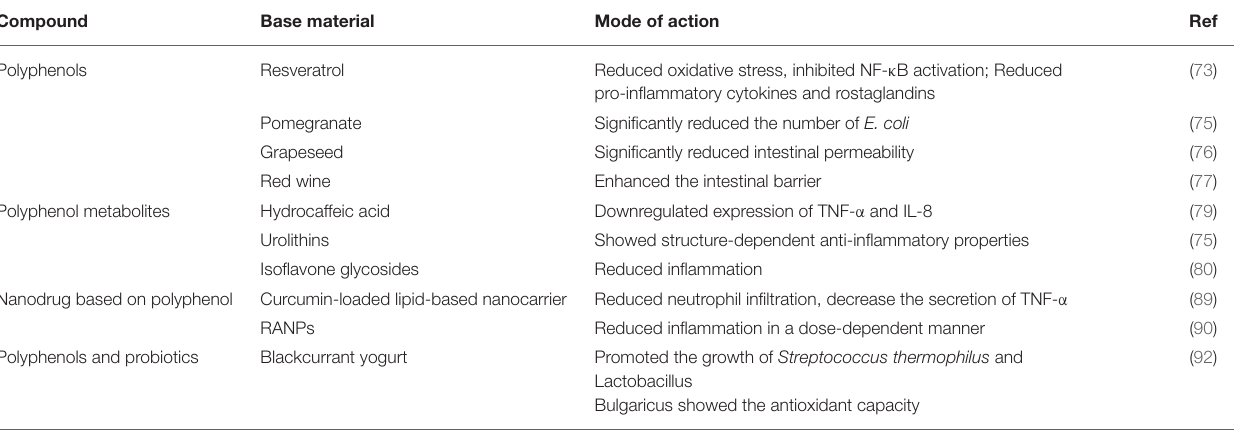
TABLE 1 | Effect of polyphenols on inflammatory bowel